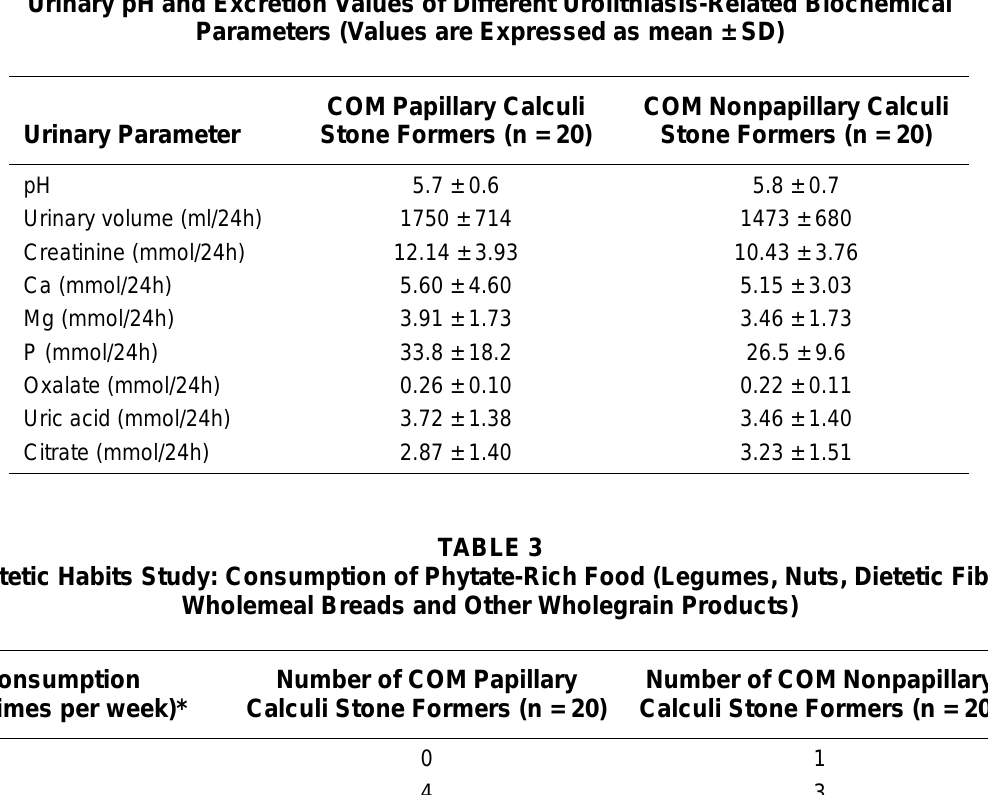
Urinary pH and Excretion Values of Different Urolithiasis-Related Biochemical